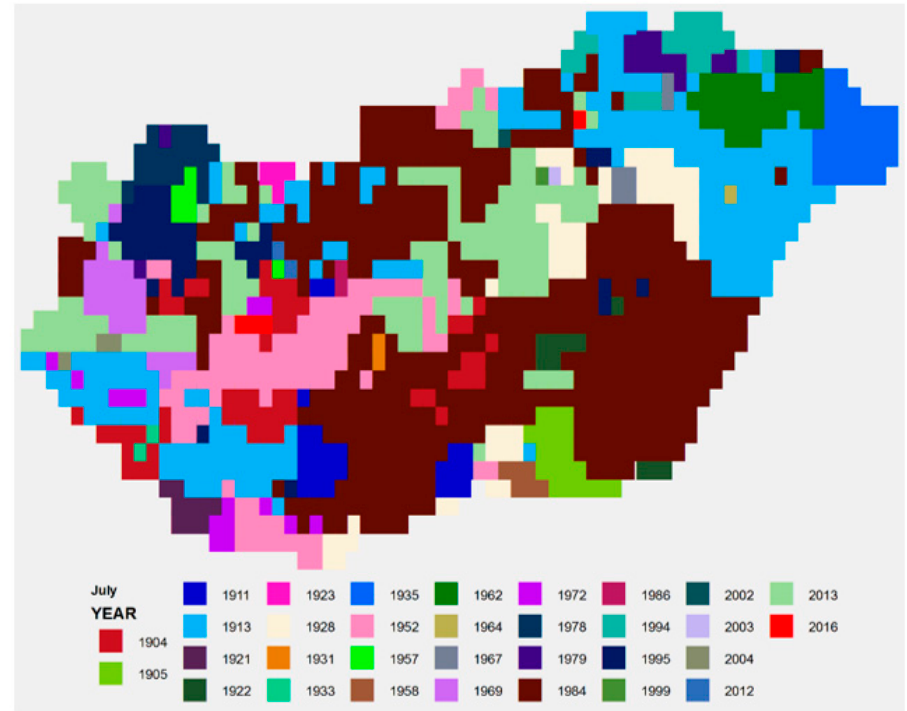
Figure A11. July: Year of maximum SPTI values, 1871–2020.